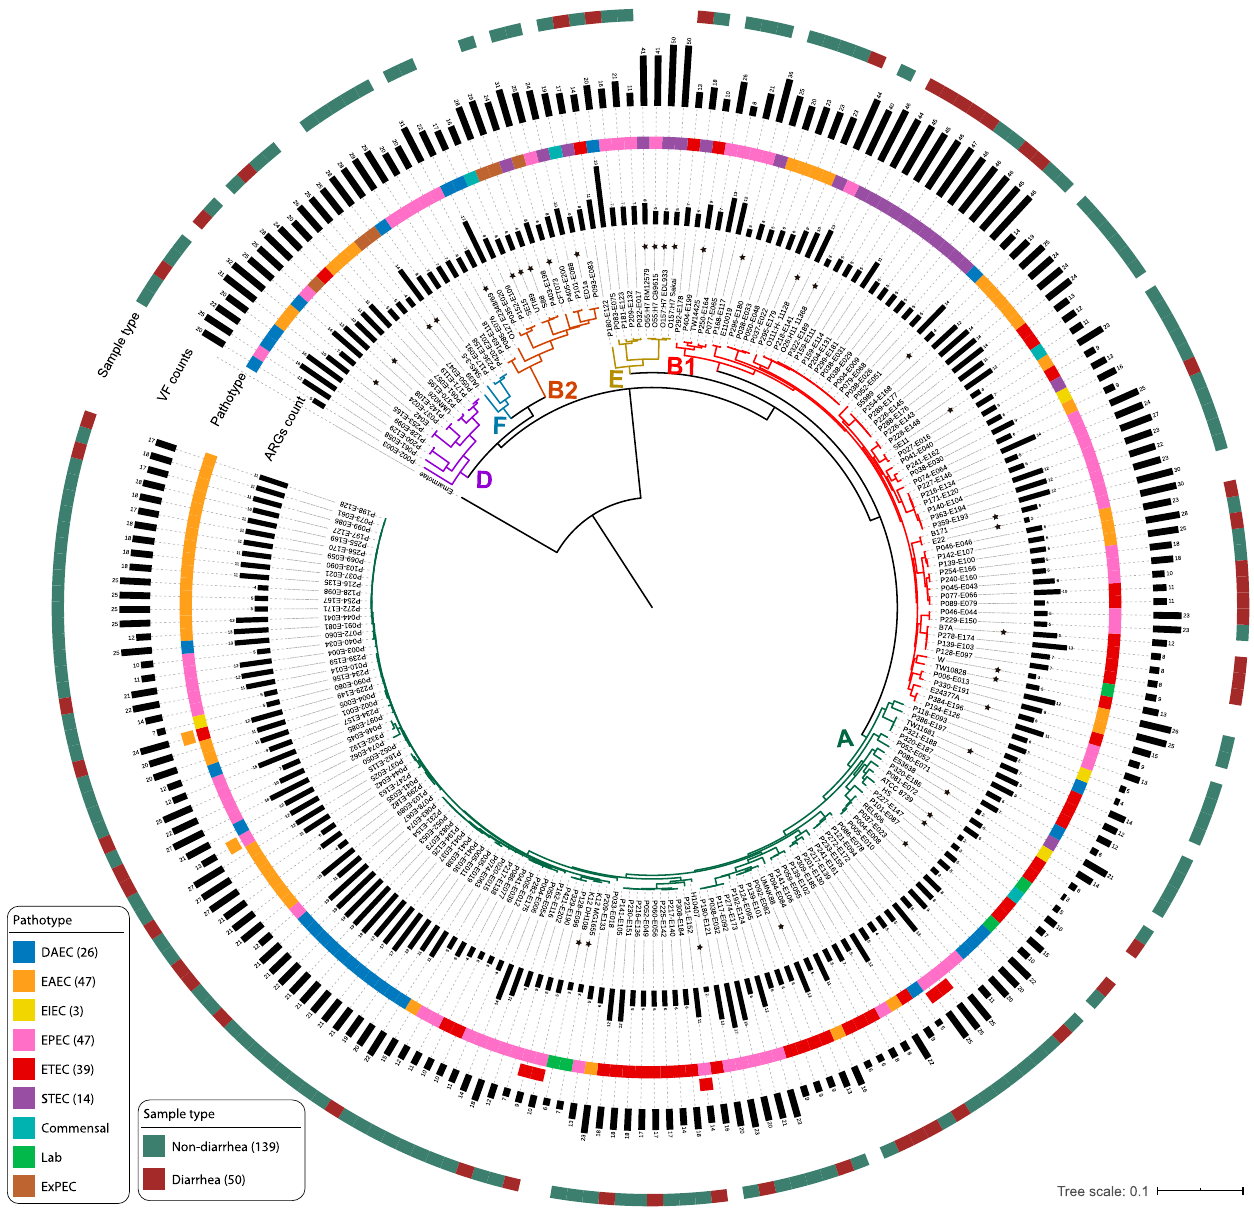
Fig. 5 | Diarrheagenic E. coli isolates are phylogenetically diverse and encode many ARGs and VFs. Phylogenetic tree inferred from core-genome alignment of 189 E.coli isolates(thisstudy)and 40published E.coli reference genomes(marked by *). Phylogroupsaredepicted as colored branchesof the tree. Annotations, from